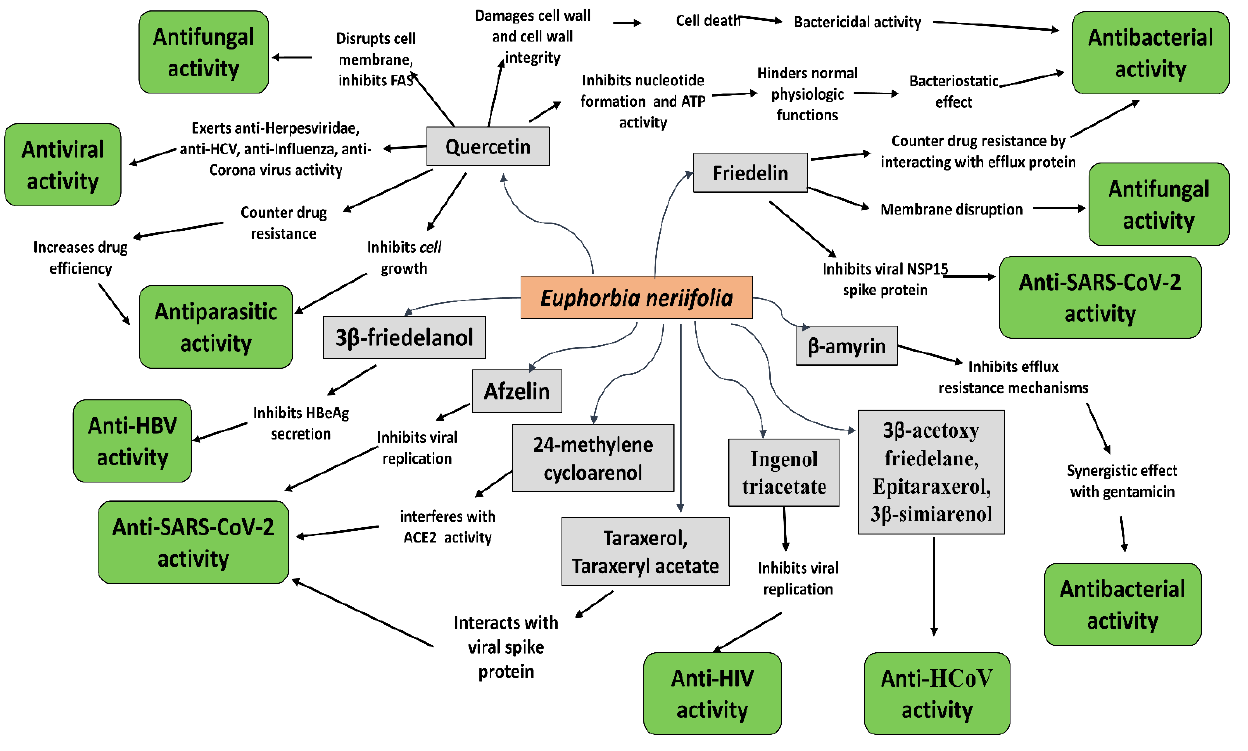
Figure 3. Antimicrobial activities of the major phytochemicals obtained from E. neriifolia .